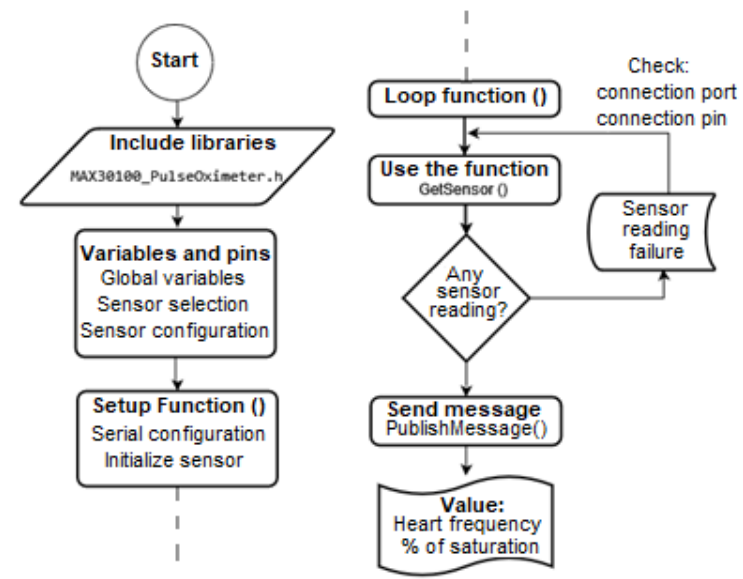
Figure 4. Pipeline reporting the modules’ structure proposed.